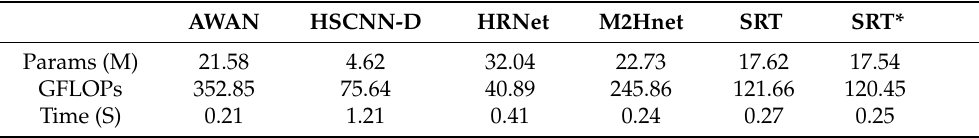
Table 11. The complexity comparison of different